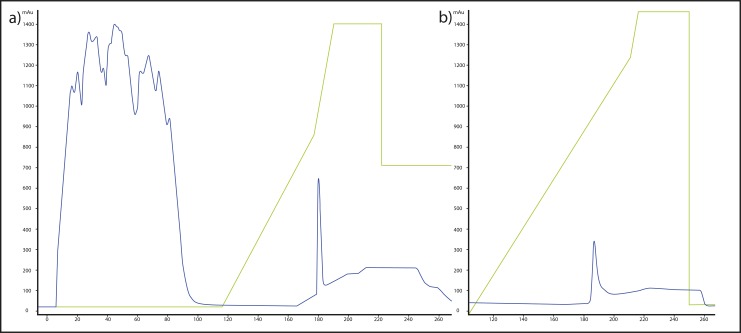
Chromatograms of rBuLIF-GFP protein during affinity purification using Anti-GFP antibodies from whole cell lysate.(A) First run of chromatography for purification (SDS profile shown in Fig 1B and 1C). (B) The second run of the purification, sample obtained from the first run peak was injected into the column for the second round of purification (respective SDS profile is shown in Fig 1D). The blue line in the chromatogram indicates the elution profile of the proteins while the green line shows the gradient applied.